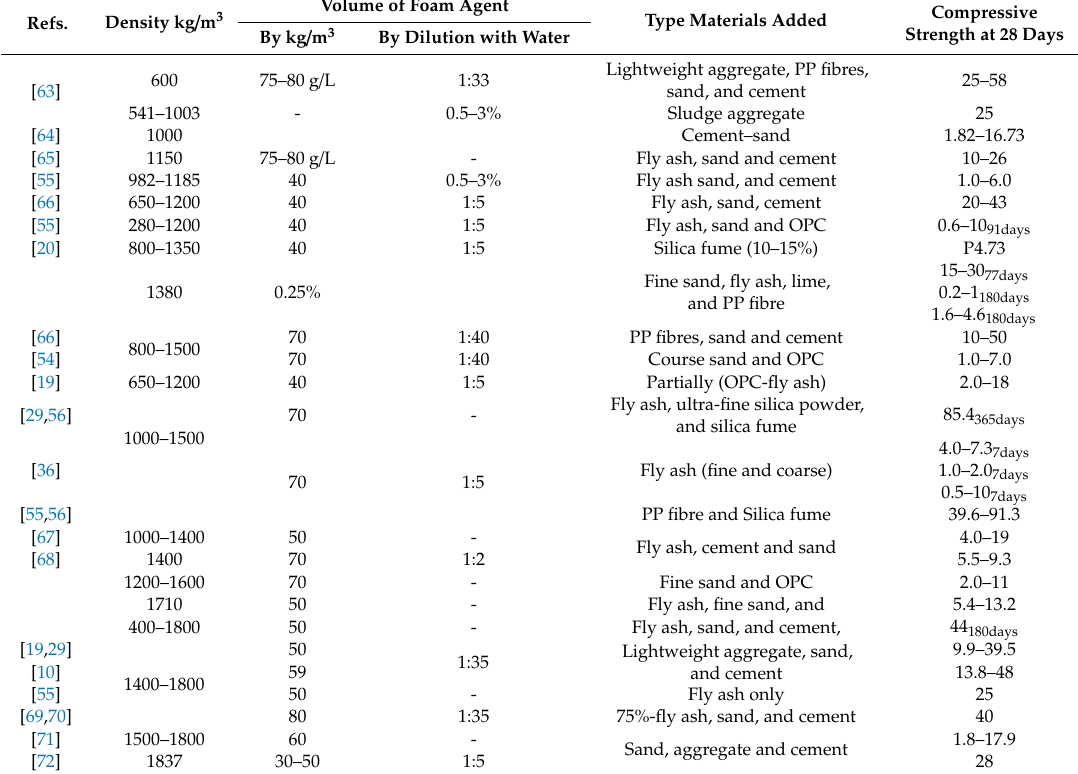
Table 2. Properties of FC with different dilution of foaming agent.